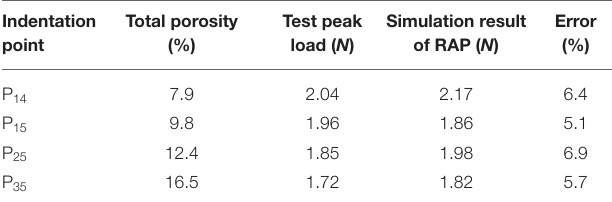
TABLE 5 | The simulation results of the RAP nanoindentation